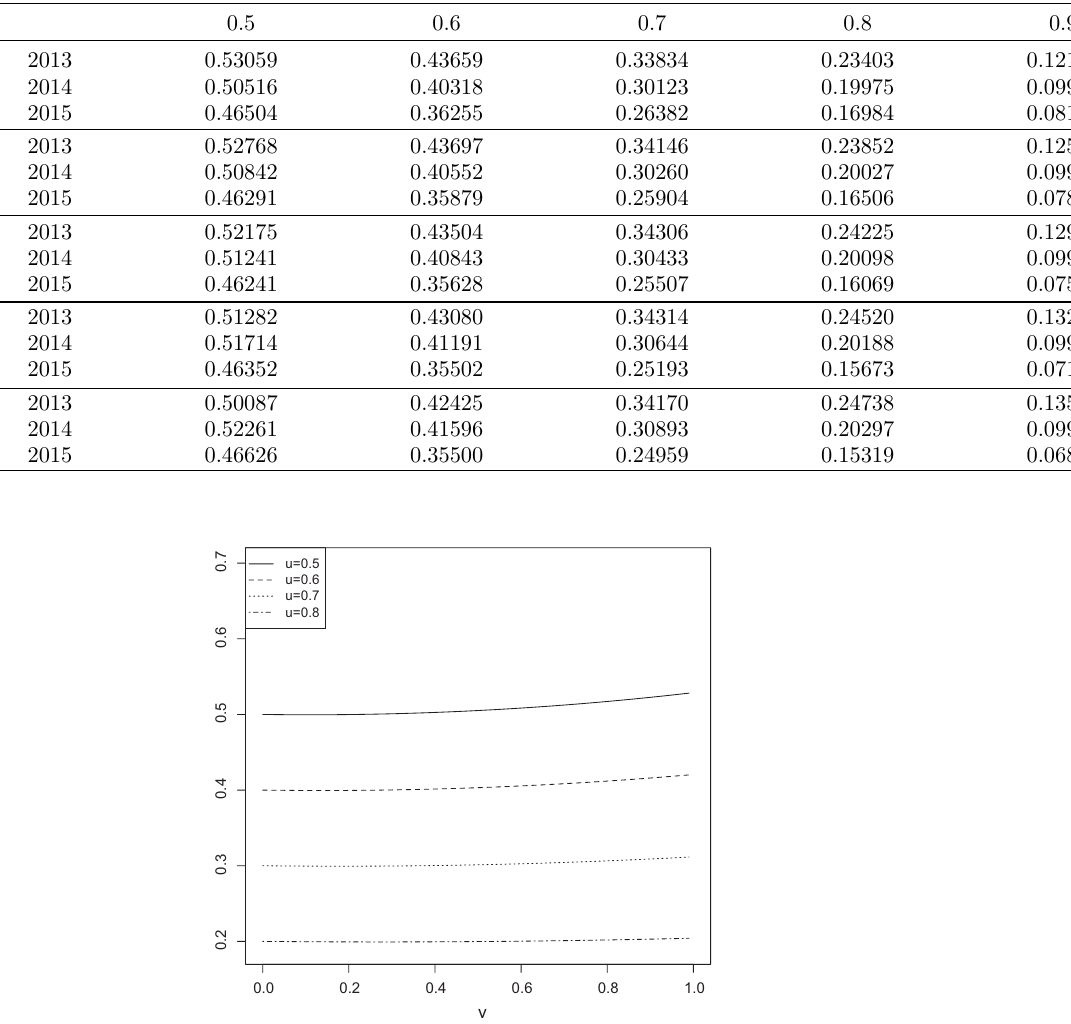
Figure 5. ^ P ð U > u ¼ 0 : 9 j V > v Þ according to equation (2), for v 2 ½ 0 ; 1 (cid:3) ; years: 2013, 2014 and 2015. ^ Table 3. P ð U > u j V > v Þ according to equation (2) with u , v = 0.5, 0.6, 0.7, 0.8 and 0.9.